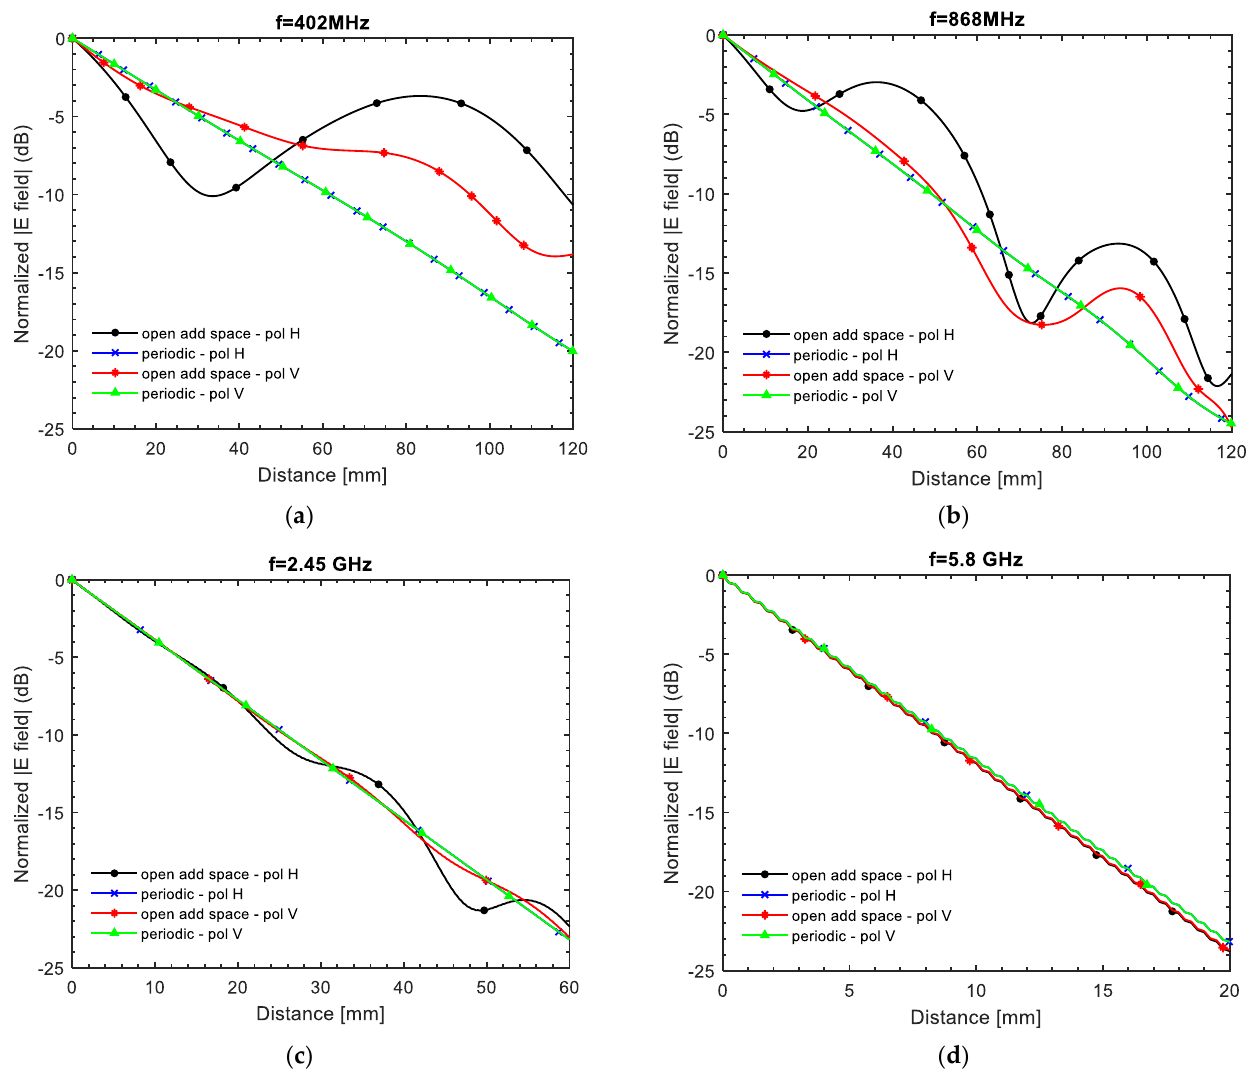
Figure A4. Normalized E-field with open add space vs. periodic boundaries for both polarizations and different frequencies: ( a ) f = 402 MHz, ( b ) f = 868 MHz, ( c ) f = 2.45 GHz and ( d ) f = 5.8 GHz.